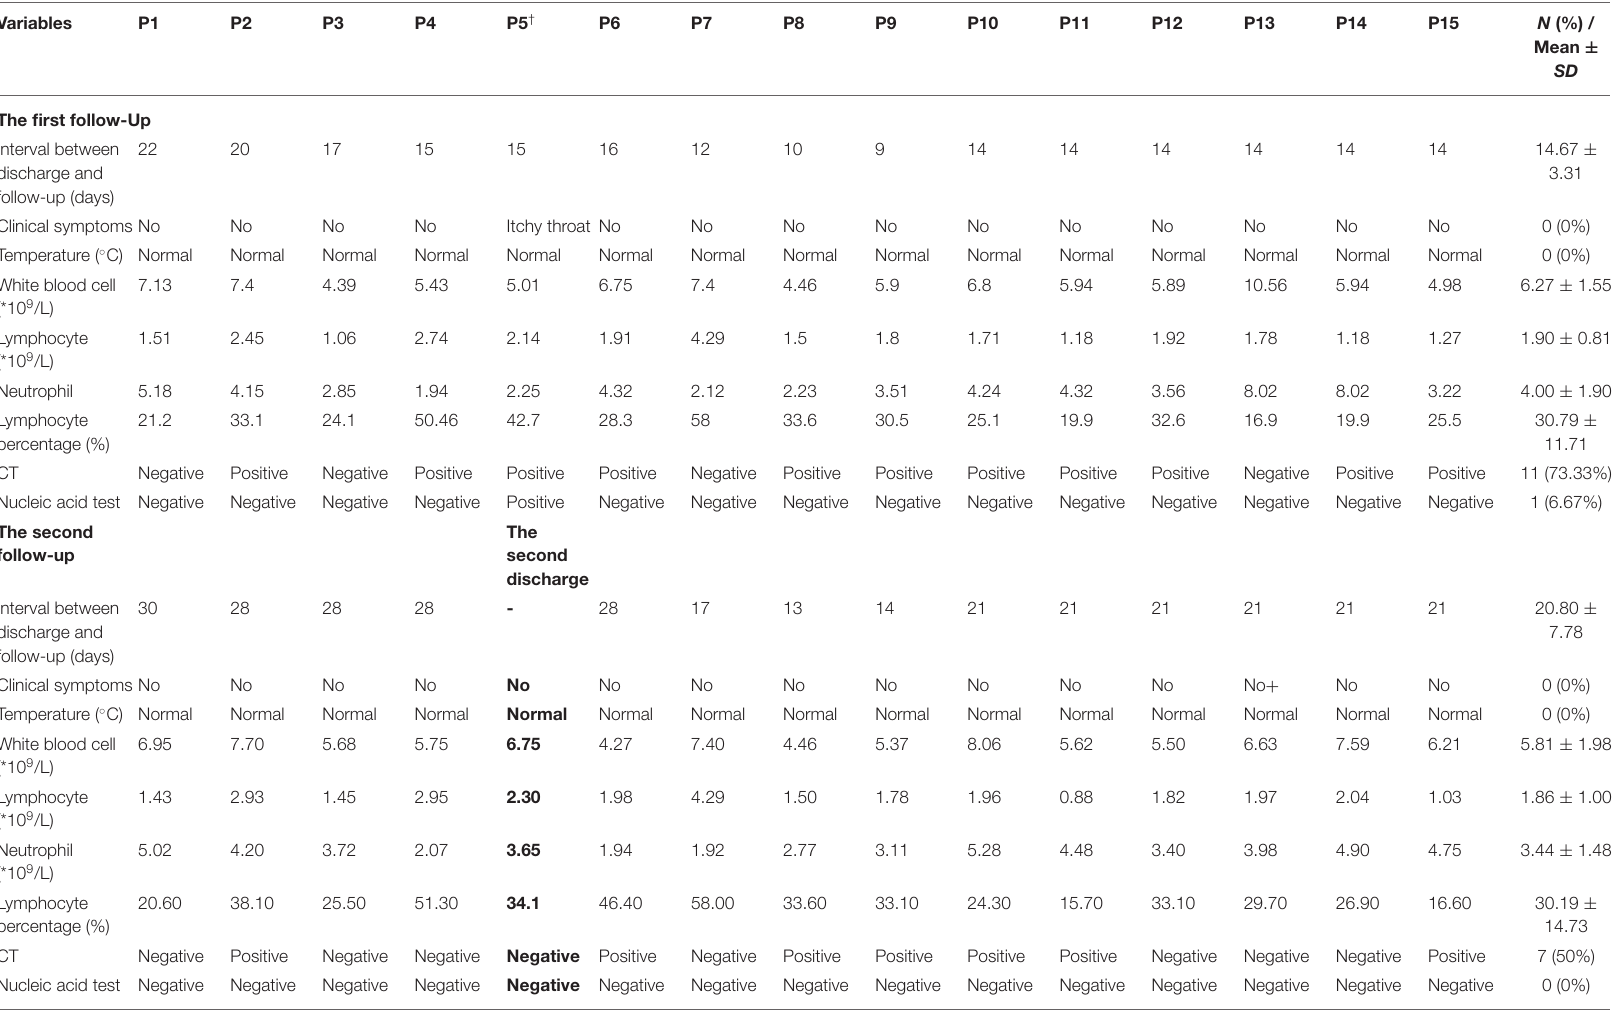
TABLE 2 | The follow-up results of discharged patients with COVID-19.